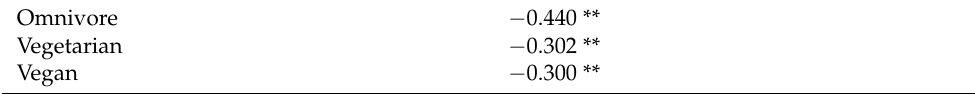
Table 3. Pearson’s correlation of diet quality and depressive symptoms split by dietary